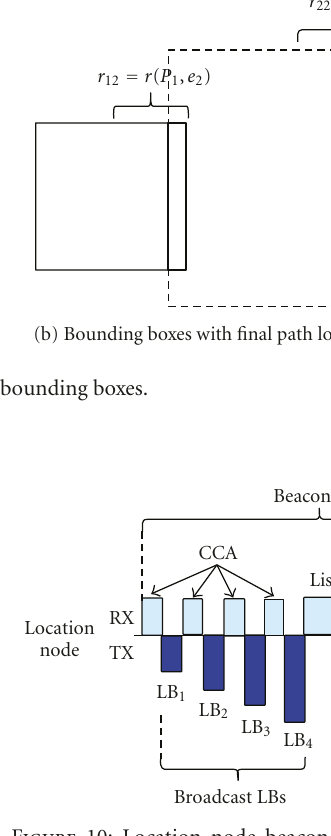
Figure 10: Location node beacon cycle using contention-MAC-